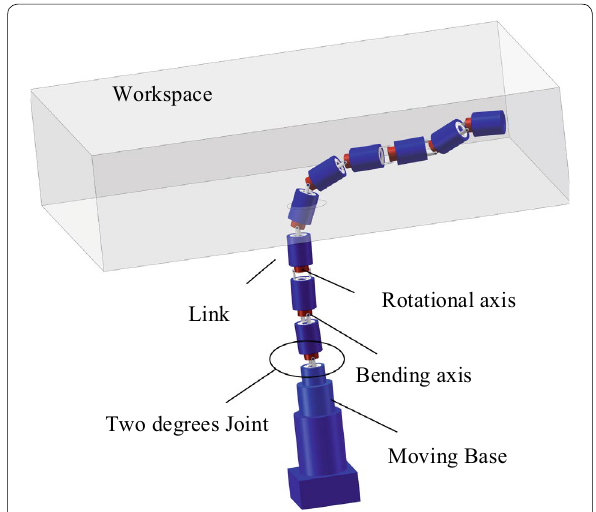
Figure 1 Redundant modular manipulator